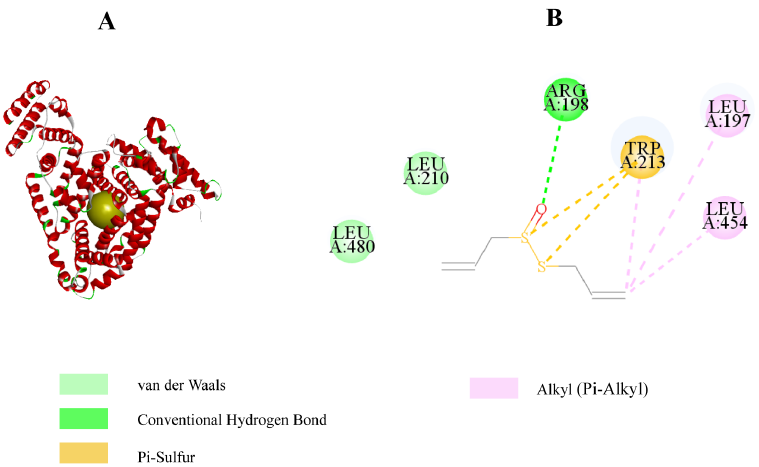
Figure 7. Docking analysis of allicin with BSA by Discovery Studio 4.5. ( A ) Protein Data Bank obtained the molecular structure of BSA (PDB ID: 4JK4), and the best conformation was obtained after docking with allicin by Discovery Studio 4.5 processing. ( B ) Allicin is surrounded by amino acid residues of BSA and interacts with arginine residues of BSA via hydrogen bonding (green dashed line).